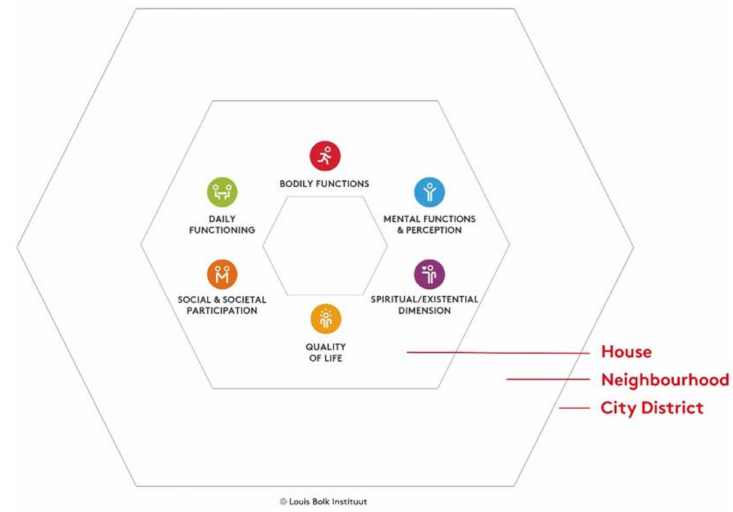
Figure 1. Bolk model for Positive Health and Living Environment: framework.